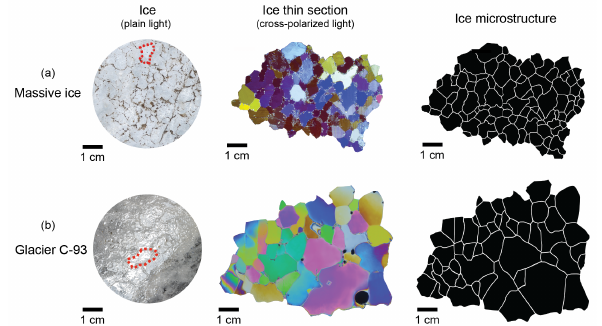
Figure 4. Comparison between the massive ice body and modern glacier ice (glacier C-93, Bylot Island). The first column shows un- processed photographs of the ice taken under a plain light with sur- ficial sediment inclusions highlighting the crystal boundaries. The dotted red line highlights one crystal. The second column shows thin sections of ice sample viewed under direct cross-polarized light. The third column shows the microstructure (crystal bound- aries) extracted from the thin-section